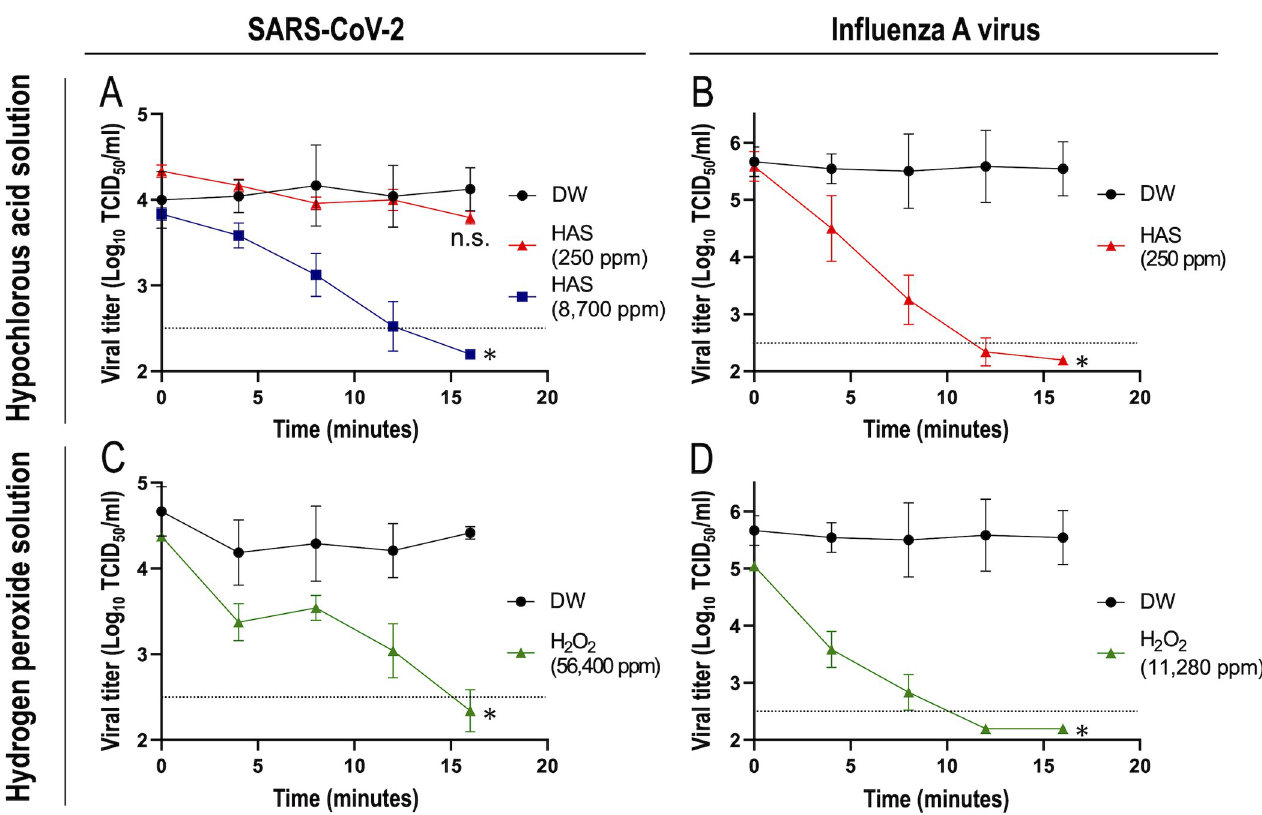
Fig 3. Inactivation of viruses by the dry fogging of disinfectants. Changes in the viral infectious titers (TCID 50 values) of SARS-CoV-2 (A and C) and influenza A virus (B and D) upon dry fogging with hypochlorous acid solution (HAS) (A and B), hydrogen peroxide solution (H 2 O 2 ) (C and D), or distilled water (DW) (A, B, C, and D) were evaluated, as described in the Materials and methods. Horizontal dotted lines in the graphs show the detection limit of the viral titer. � P < 0.0001 compared with DW using a two-way ANOVA. n.s., not significant. Each data point represents the average and standard deviation obtained from more than three repeated